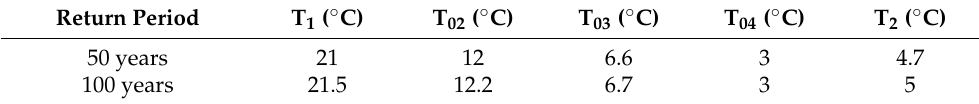
Table 6. Values of temperature bases for different return periods of unpaved steel box